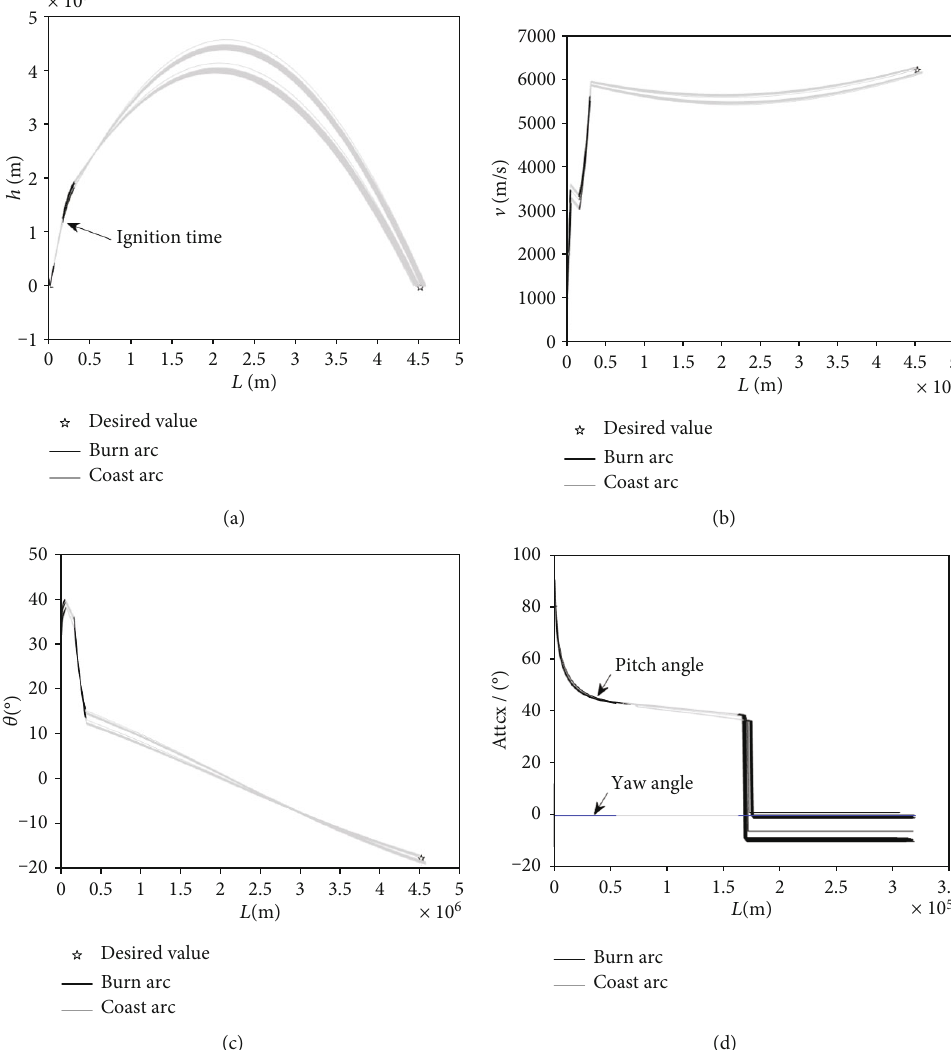
Figure 7: Pro fi les of the state parameters of 250 Monte Carlo runs for solid rockets. (a) The altitude. (b) The velocity. (c) The fl ight path angle. (d) The guidance